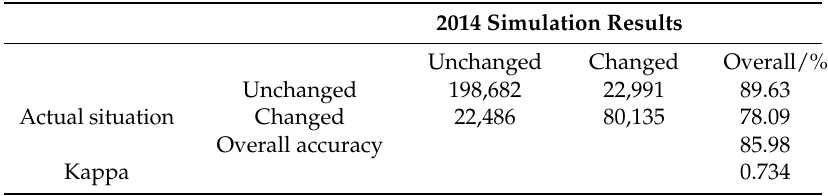
Table 2. Comparison between the simulation results of the CART-CA model and the actual situation.